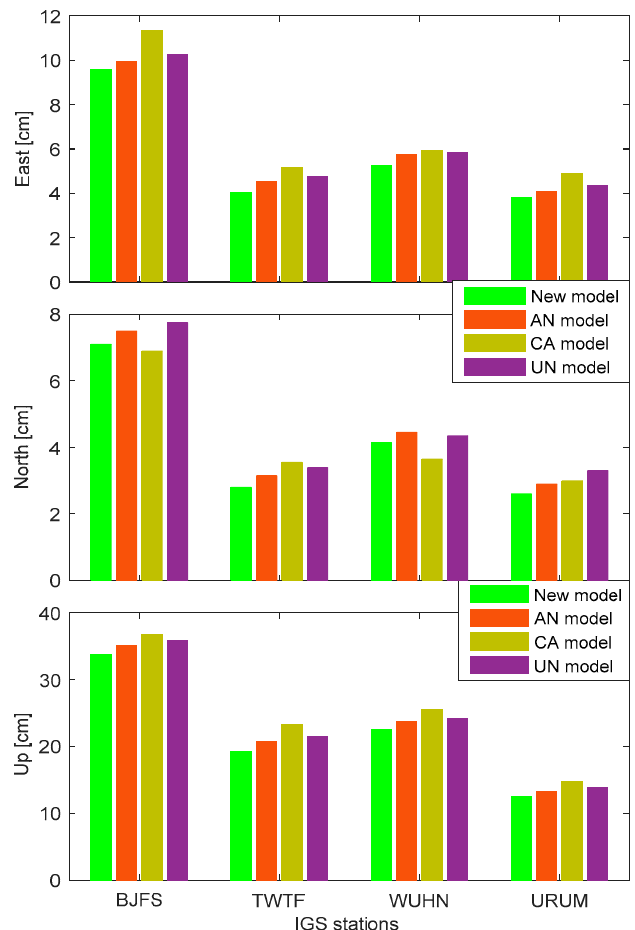
Figure 8. RMS of GNSS PPP kinematic positioning errors. See the main text for an explanation of abbreviations.